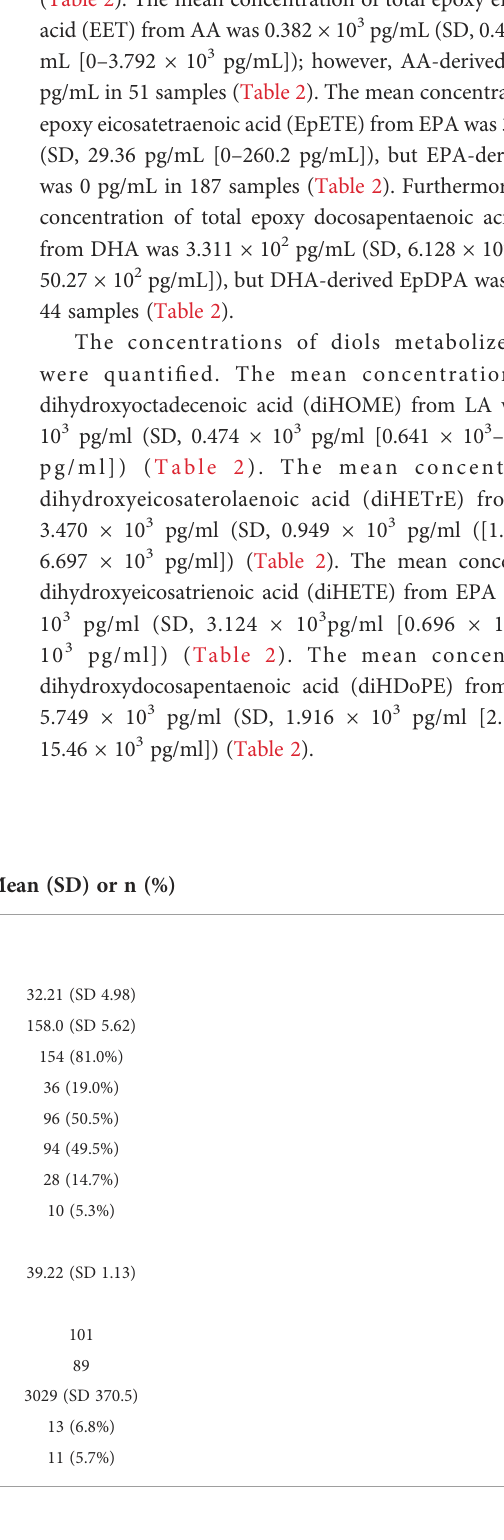
(Table 2). The mean concentration of total epoxy eicosatrienoic